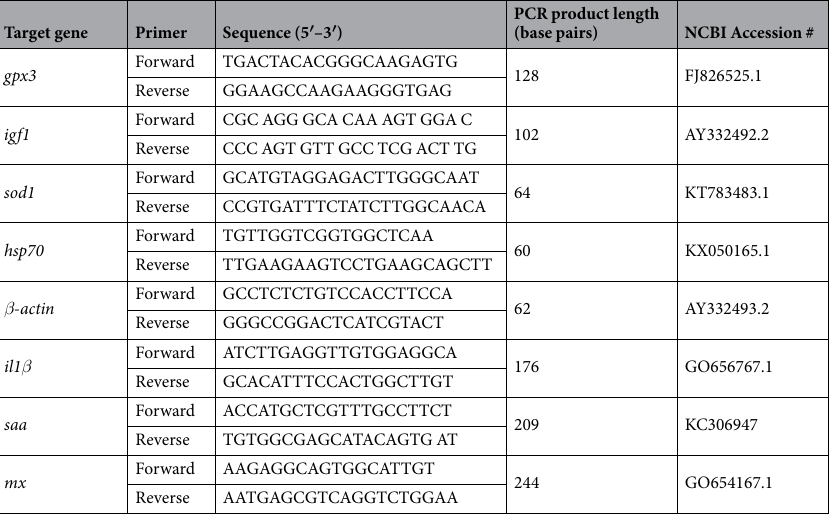
Table 1. Primers for genes in Perca flavescens